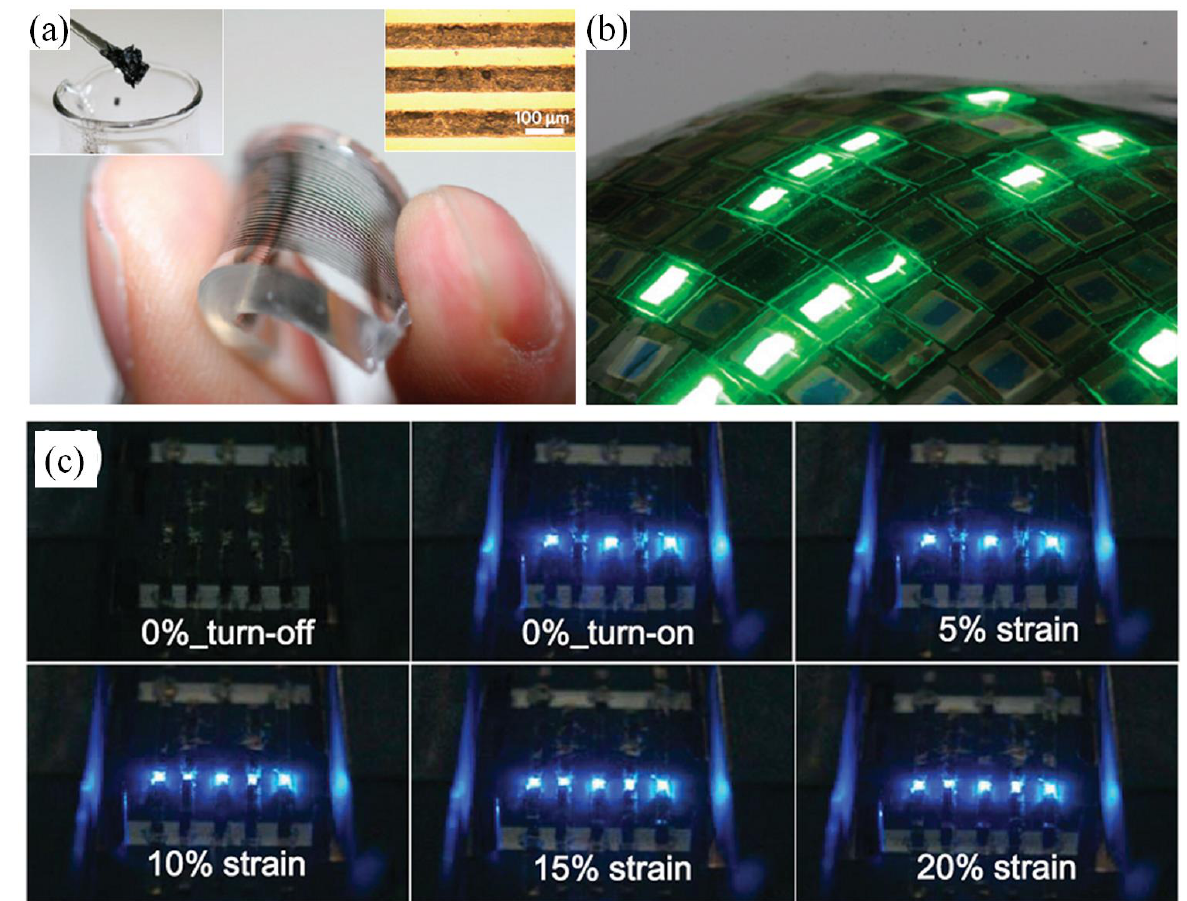
Figure 4: (a) A photograph showing the stretchable elastic conductors printed on a PDMS substrate using the SWCNT paste (left inset pho- tograph) with linewidth of 100 µm (micrograph on the right inset). (b) A photograph of the stretchable display fabricated by